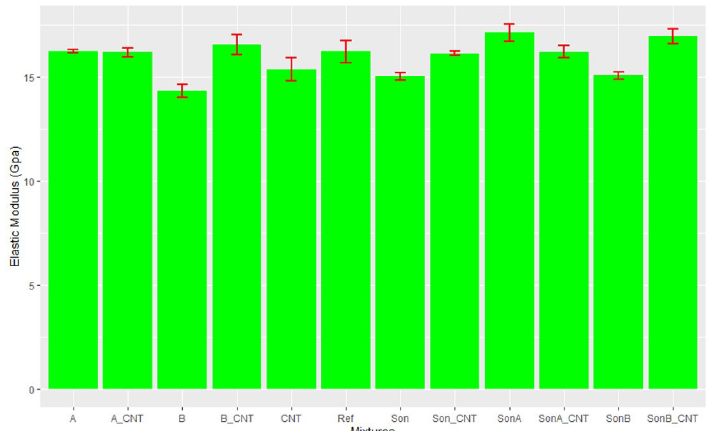
Figure 11. Elastic modulus of the hardened Portland cement pastes.